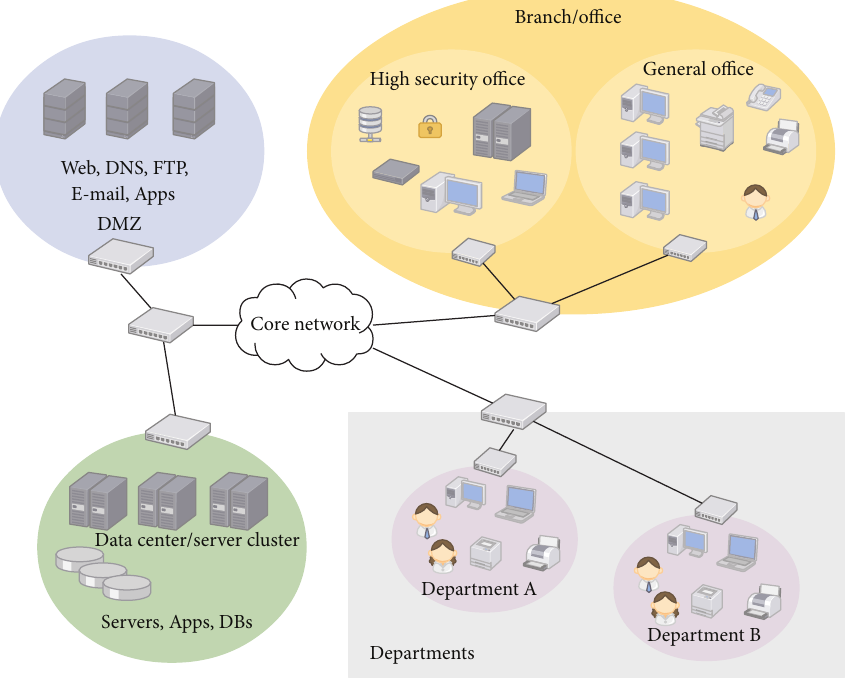
Figure 2: Example enterprise network architecture.